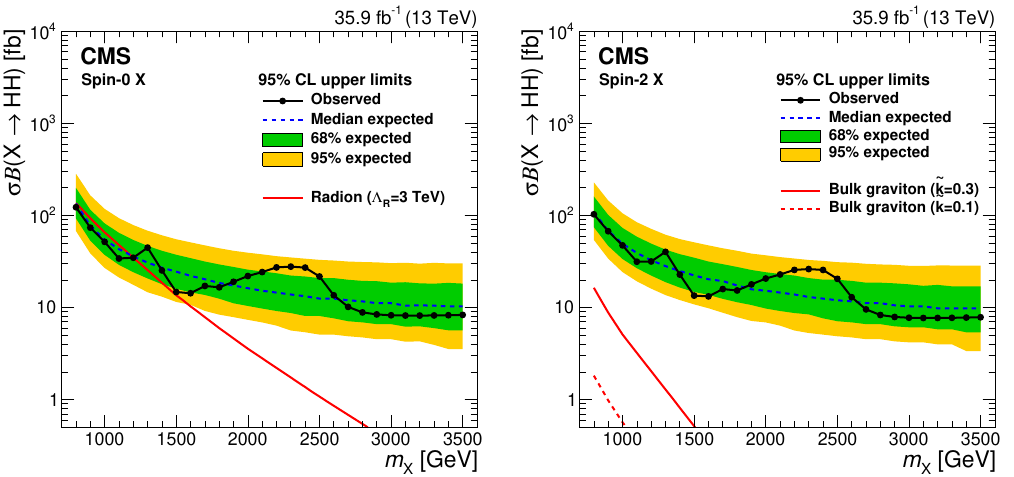
Figure 7 . Observed and expected 95% CL upper limits on the product of the cross section and branching fraction to HH for a generic spin-0 (left) and spin-2 (right) boson X, as a function of mass. Example radion and bulk graviton predictions are also shown. The HH branching fraction is assumed to be 25 and 10%,